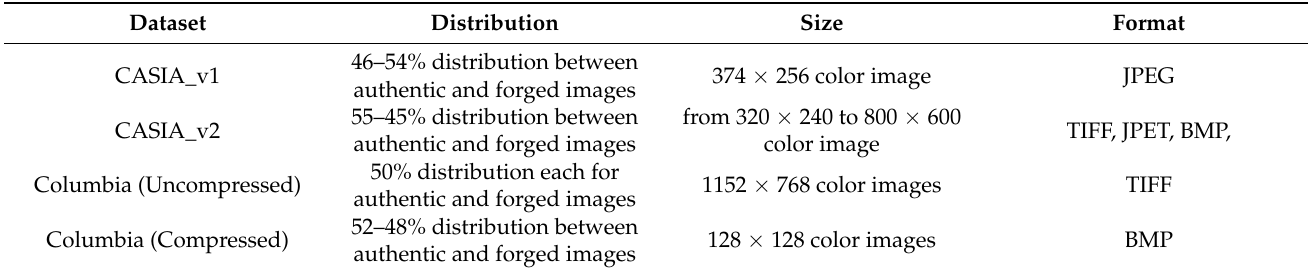
Table 1. Difference between CASIA_v1 and CASIA_v2 datasets.